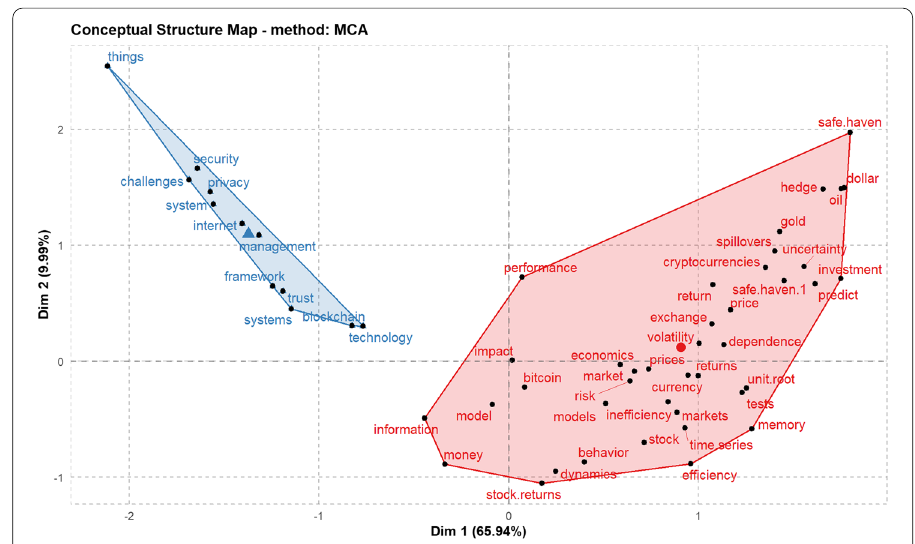
Fig. 13 Conceptual structure map using MCA method. Source : Own